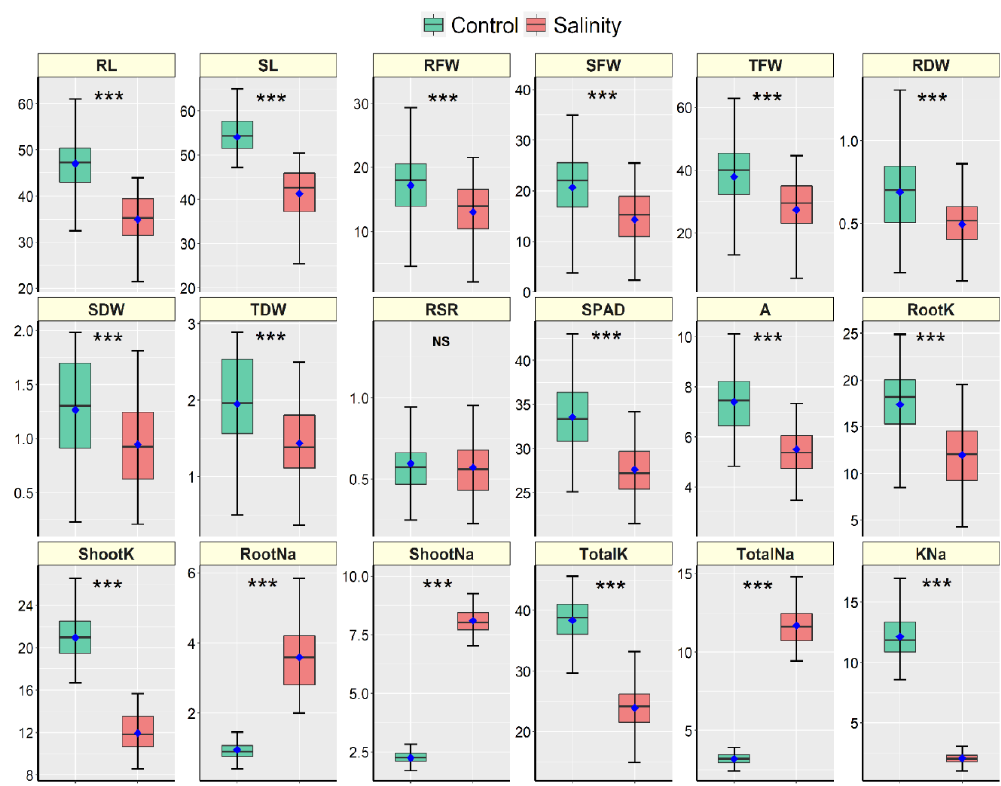
Figure 2. Boxplots illustrating the descriptive statistics of morpho-physiological and biochemical measured traits in 21-day-old seedlings of 18 hybrid maize cultivars grown in control and salt conditions under a hydroponic system. The blue points are treatment means, and the horizontal lines dividing the box represent the medians. The lower and upper box boundaries, as well as the lower and higher whiskers, reflect the Q1 (25th percentile), Q3 (75th percentile), minimum (Q1–1.5IQR) and maximum (Q1 + 1.5 IQR) values, respectively. IQR denotes Interquartile Range. *** and NS denote significant variation between treatments at 0.1% levels of probability and non-significant, respectively. Units of traits are as follows: RL (Root Length, cm), SL (Shoot Length, cm), RFW (Root Fresh Weight, g), SFW (Shoot Fresh weight, g), TFW (Total Fresh Weight, g), RDW (Root Dry Weight, g), SDW (Shoot Dry Weight, g), TDW (Total Dry Weight, g), RSR (Root–Shoot Ratio), SPAD (Leaf Greenness), A (Photosynthesis rate, µ mol CO 2 m − 2 s − 1 ), RootK (Root K + concentration, mg g − 1 DW), ShootK (Shoot K + concentration, mg g − 1 DW), TotalK (Total K + concentration, mg g − 1 DW), RootNa (Root Na + concentration, mg g − 1 DW), ShootNa (Shoot Na + concentration, mg g − 1 DW), TotalNa (Total Na + concentration, mg g − 1 DW), KNa (K + –Na +